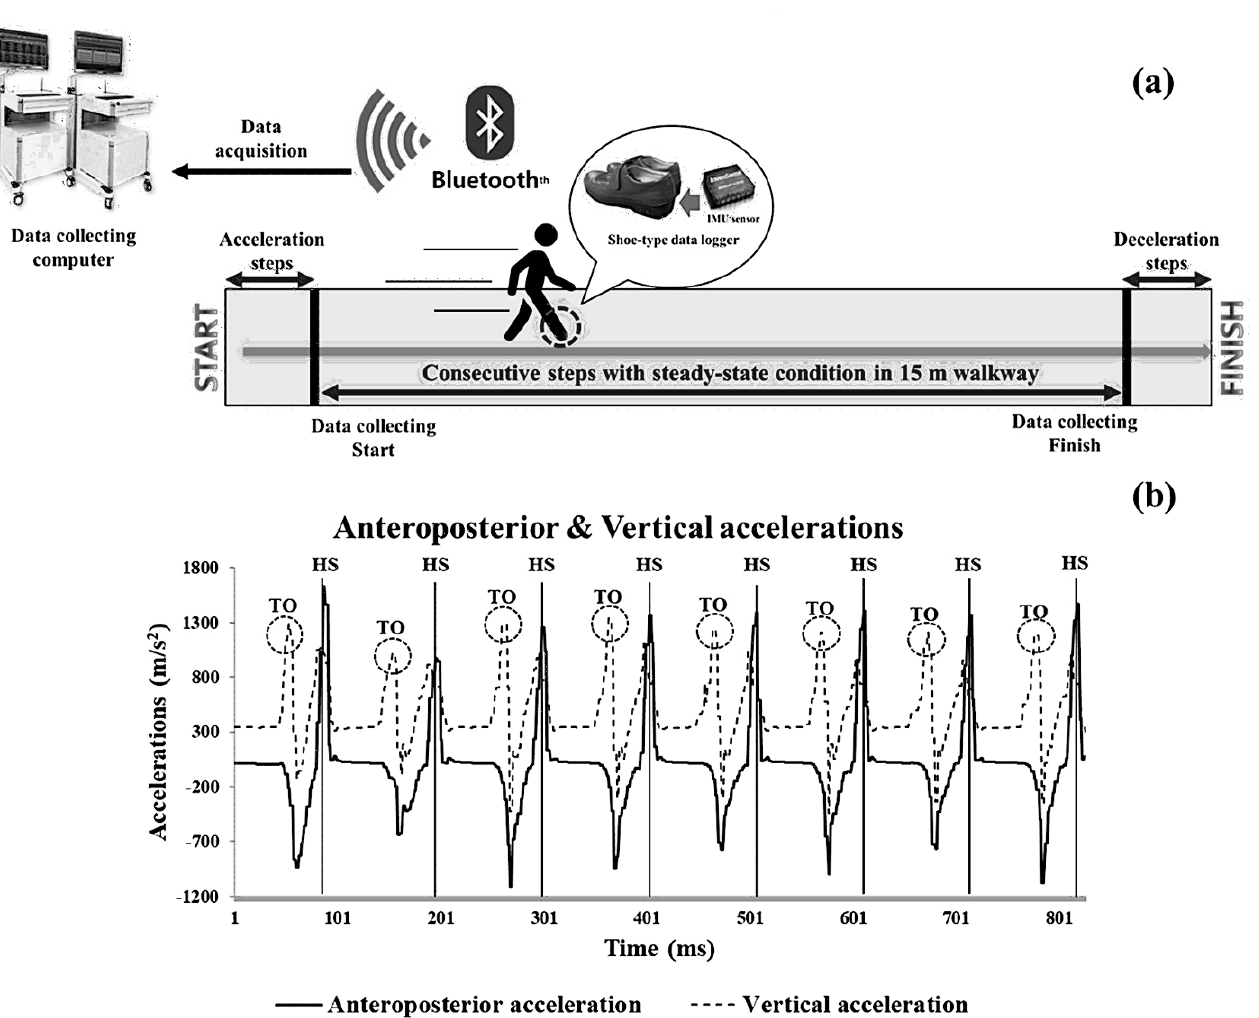
Figure 2. Experimental environment and system for the measurement and analysis phases under steady-state conditions. ( a ) Three arrows from left to right sides indicates acceleration, consecutive, and deceleration steps for the measurement phase, respectively. ( b ) Detection of walking abnomalities with the shoe-type inertial measurement unit (IMU) system is analyzed through extracted